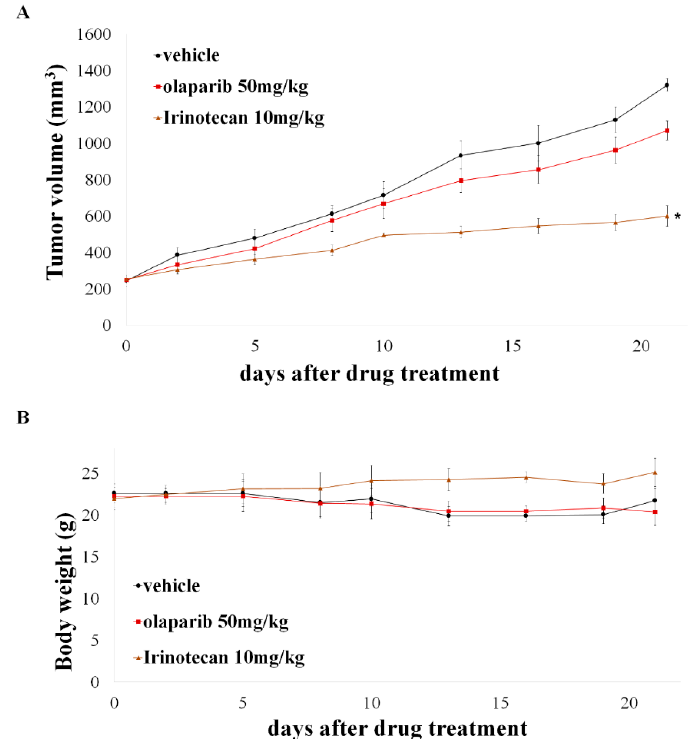
Figure 7. Irinotecan impeded tumor growth in a BRCA2 mutant PDX model with acquisition of olaparib resistance. ( A ) PDX model were treated with 50mg/kg olaparib or 10mg/kg irinotecan for 21 days (n = 4/group). The mean of tumor volumes was presented in a graph with the standard deviation (SD). * indicates p < 0.001 versus vehicle and olaparib group. ( B ) Changes in body weight were measured every three days for 21